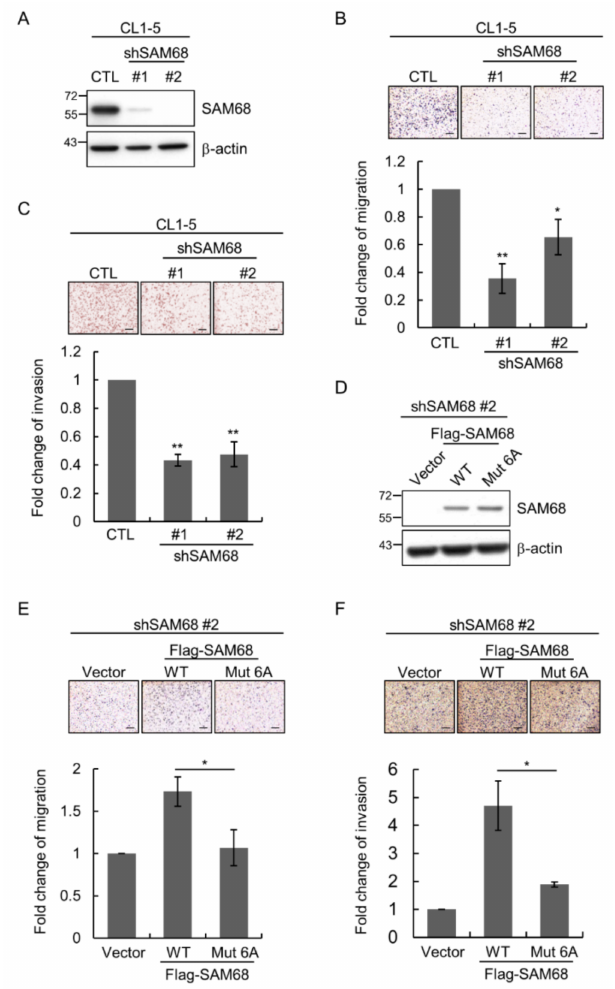
Figure 5. O -GlcNAcylation in the N -terminal region of SAM68 and its functional significance. ( A – C ) Two different KHDRBS1 -targeting shRNAs (shSAM68 #1 and #2) were used to generate independent SAM68-knockdown CL1-5 clones. The LKO vector was used as an infection control (CTL). Cells assay ( C ). ( D – F ) CL1-5 shSAM68 #2 cells were transfected by the control vector or a construct